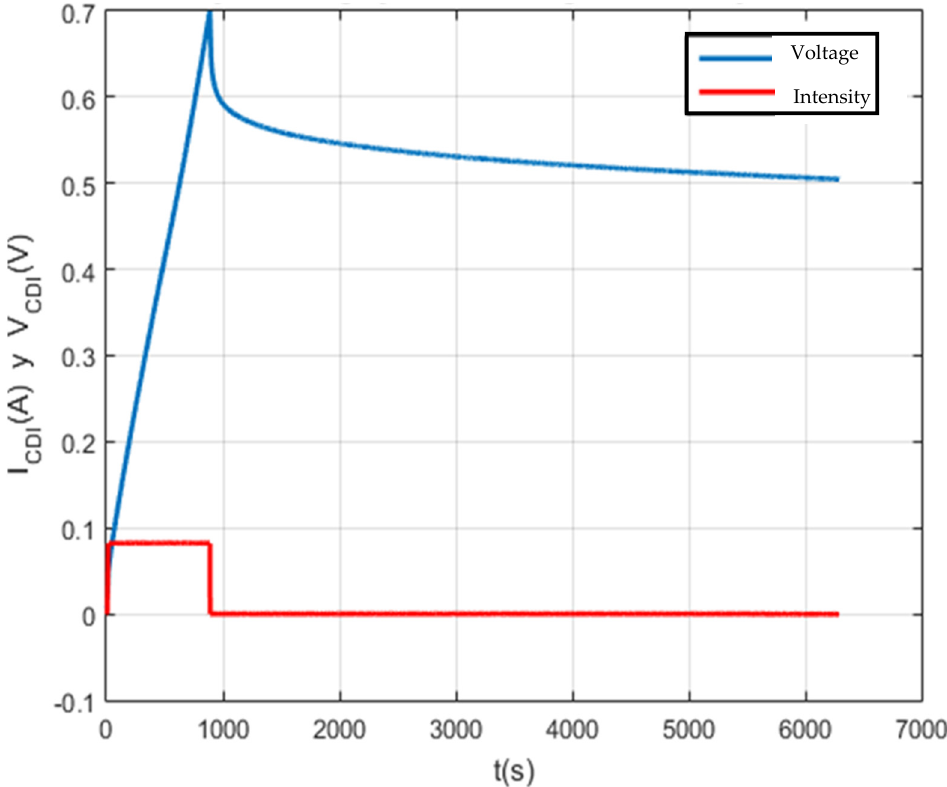
Figure 16. Charge and self-discharge test to characterize a 150 F capacitor.